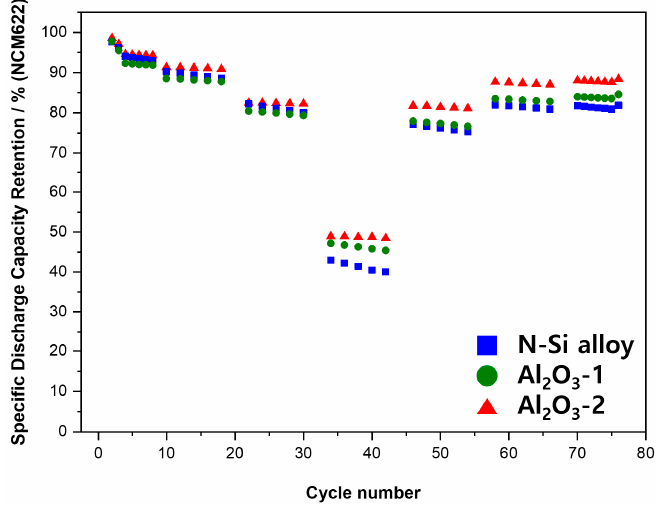
Figure 13. Results of the CC charging/discharging cycling experiments for the PFC at different C- rates. C-rates.